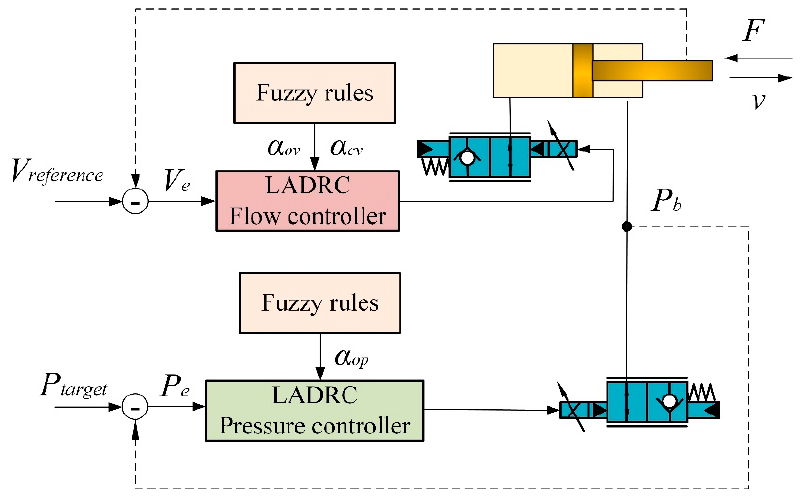
Figure 6. Compound control pressure and flow structure of IMCHB.